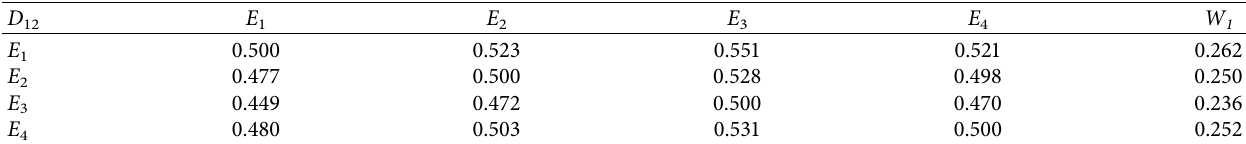
Table 9: D 12 - E fuzzy consistent matrix and relative